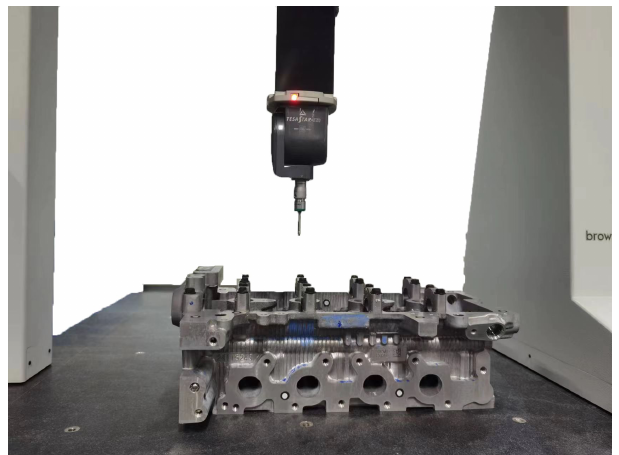
Figure 1. Cylinder block inspection